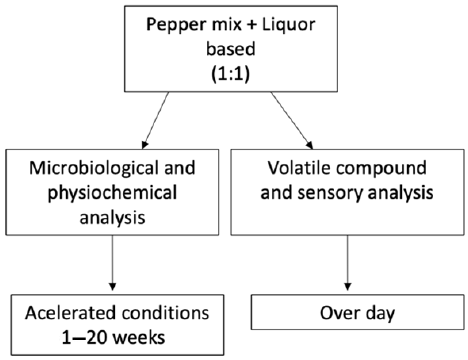
Figure 1. Process Flow Diagram.